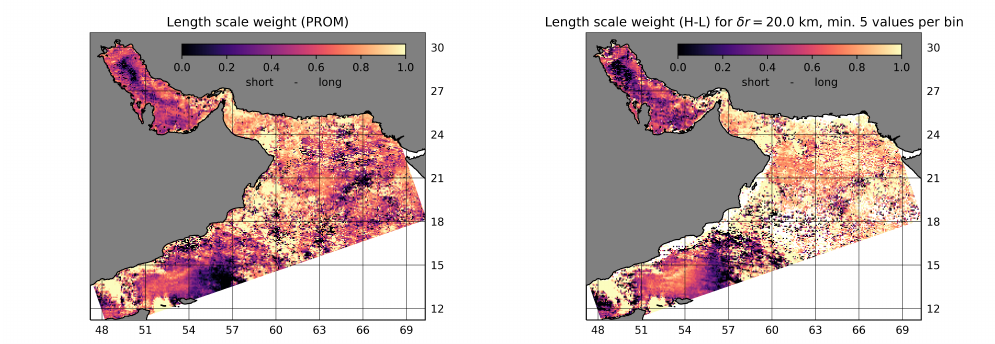
0 + a 1 ) ) computed using